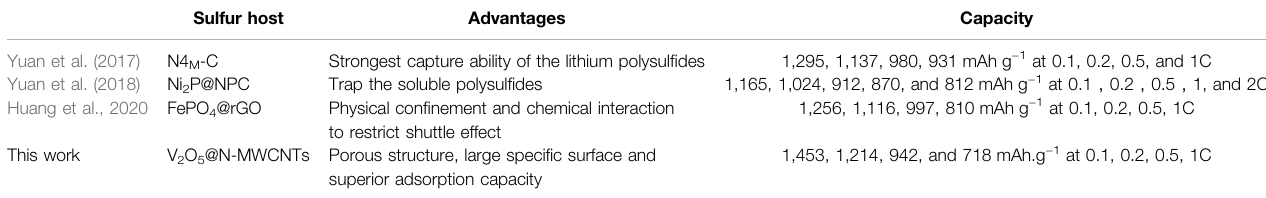
TABLE 1 | Comparison of Li-S Battery Performance with different materials. Sulfur host Advantages